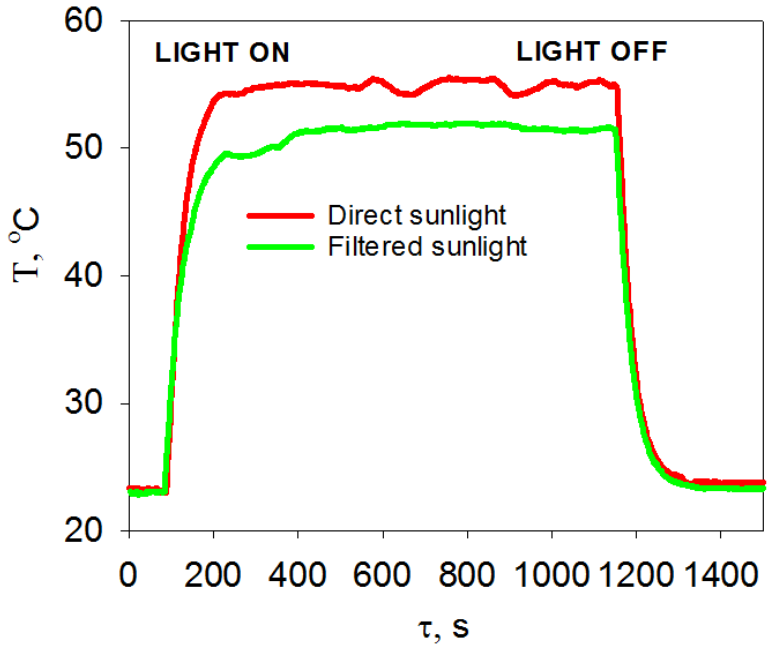
Figure 2. Temperature response of the SubPzS 3 H 0 film on glass exposed to the direct (red curve) or filtered (green curve) 1-sun illumination in